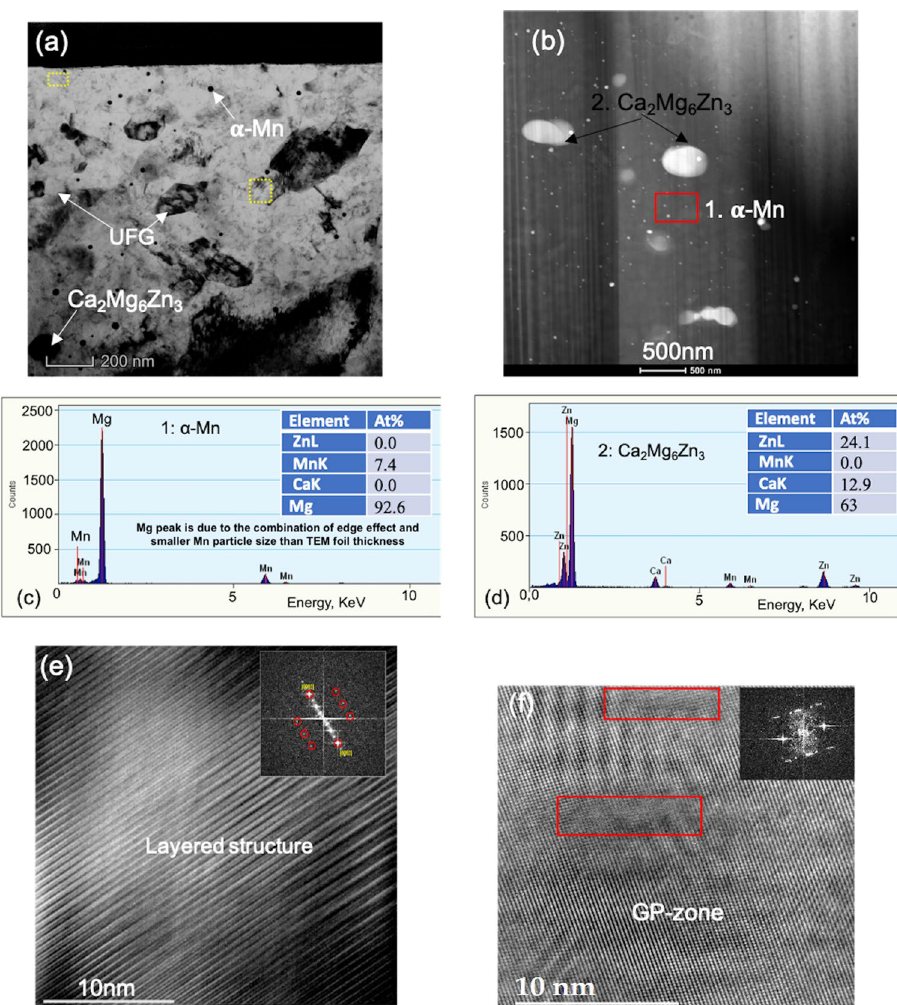
EDS scan showing ( c ) alpha-Mn (p#1), and ( d ) Ca 2 Mg 6 Zn 3 (p#2), the ( e ) 6H layered structure, corresponding to the extra spots in the FFT patterns; ( f ) GP-zones (marked by the extra spot in the inserted FFT image) for the peak-aged